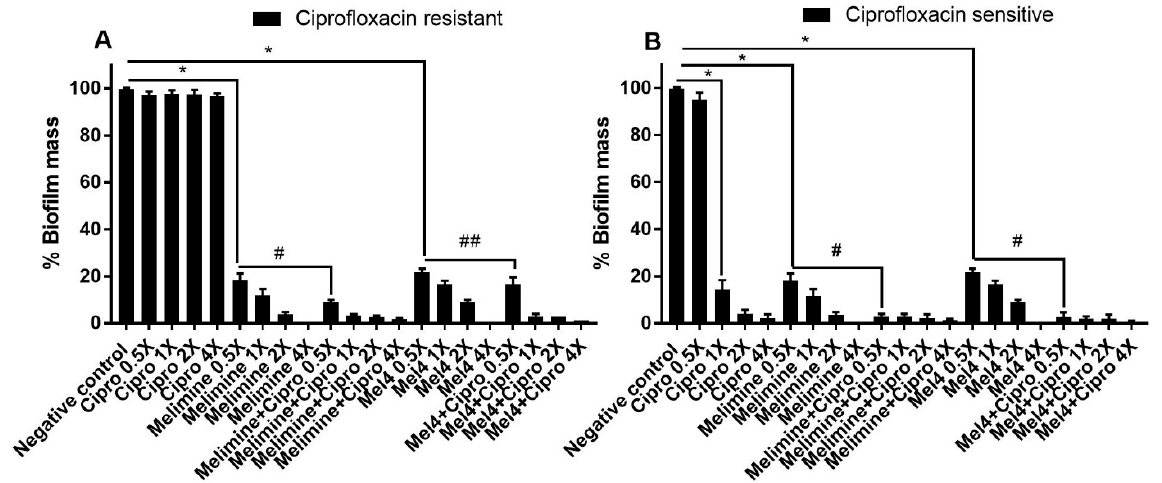
Figure 3. Inhibition of biofilm formation of S. aureus ATCC 25923. Biofilm formation of the ciprofloxacin-resistant ( A ) or sensitive ( B ) cells of S. aureus ATCC was inhibited by various concentrations of melimine, Mel4 and ciprofloxacin alone or in combination. The strain was made resistant to ciprofloxacin by sub-passage for 30 days at a sub-MIC concentration. * represent significant ( p < 0.001) decreases compared to the negative control (bacteria grown in the absence of antibiotics). # indicates significant ( p < 0.001) decrease for the combinations compared to melimine or Mel4 alone while ## indicates p = 0.036 compared to Mel4 alone. Means ( ± SD) of three independent repeats in triplicate. Negative control = bacteria grown in the absence of antimicrobials, Cipro = ciprofloxacin.